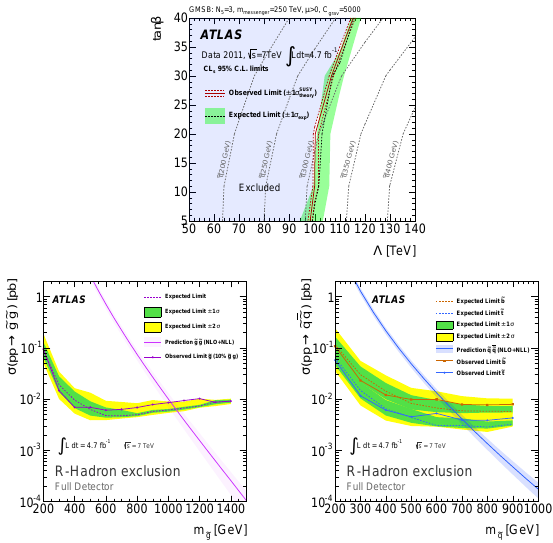
Figure 3. Limits on the SUSY-breaking mass scale, Λ , and the ratio of the vacuum expectation values of the two Higgs dou- blets, tan β , in GMSB models (top), cross-section upper limits for gluino (bottom left) and squark (bottom right) R -hadrons in the full-detector search.